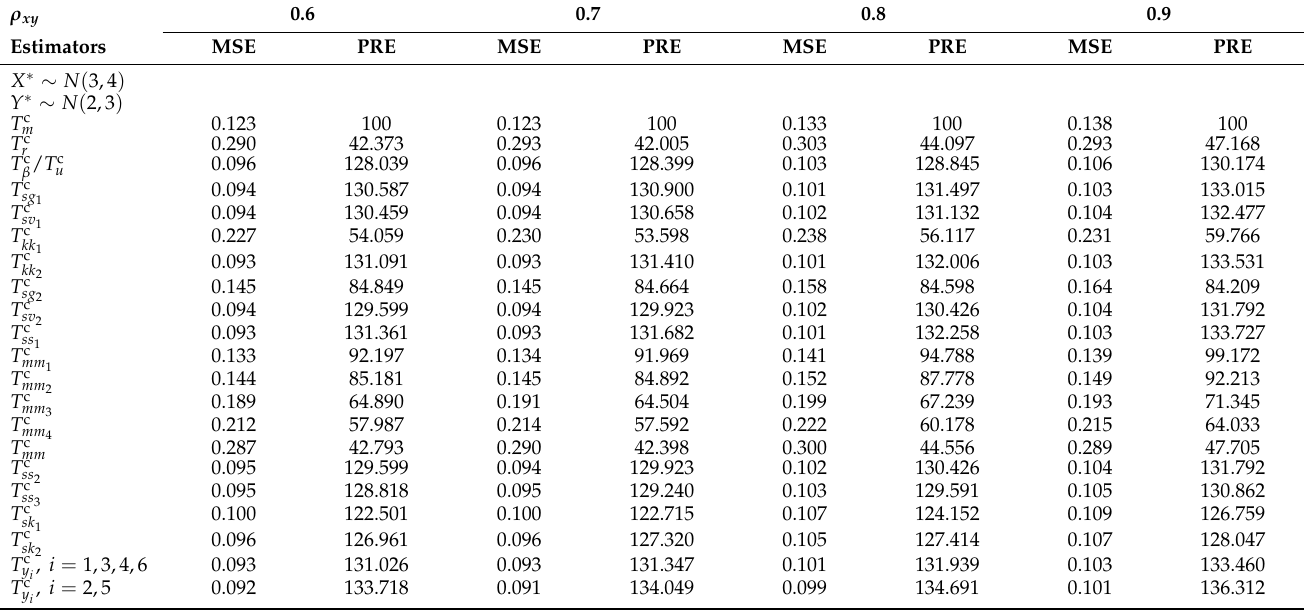
Table 4. MSE and PRE of combined estimators utilizing hypothetically drawn Normal